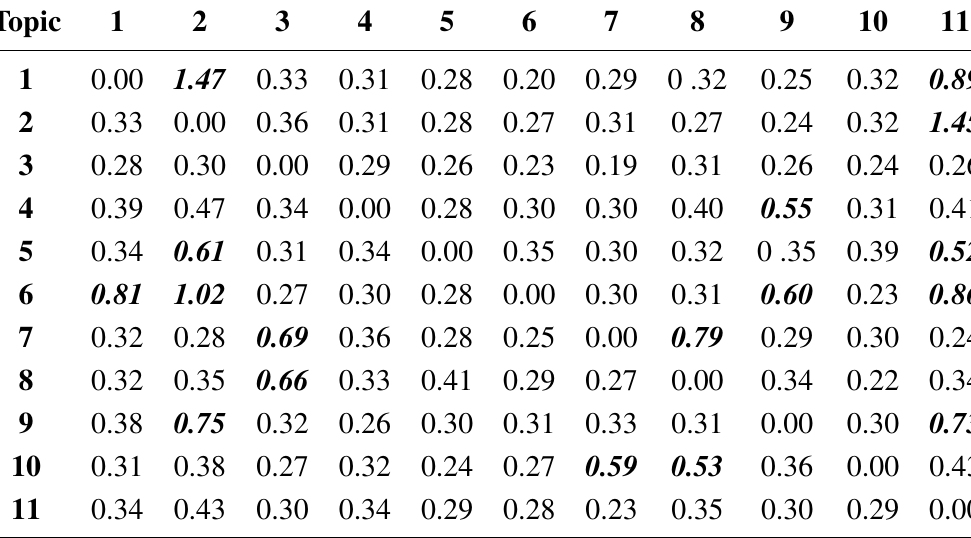
Table 3. Causal matrix for the subway